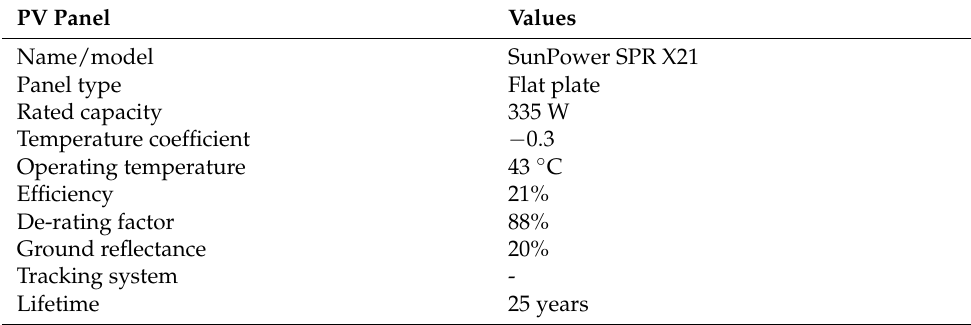
Table 10. Technical data of the PV panel.